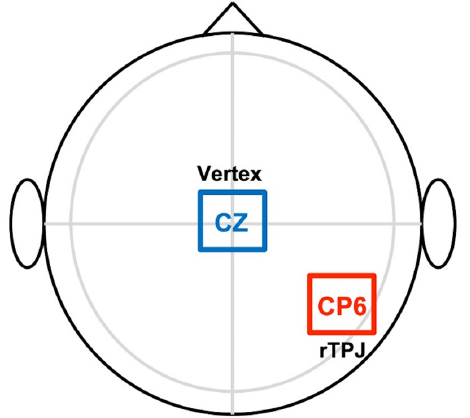
Figure 1. Montage of tDCS electrodes, for both the sham and the active condition.